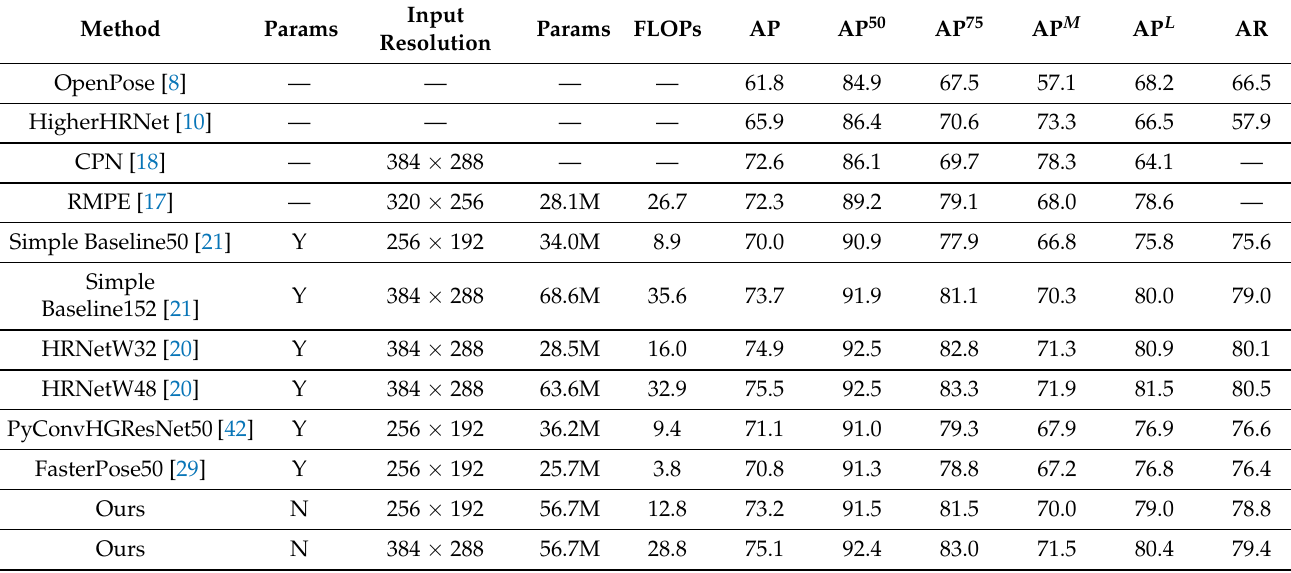
Table 4. Comparison results of different models on the COCO test